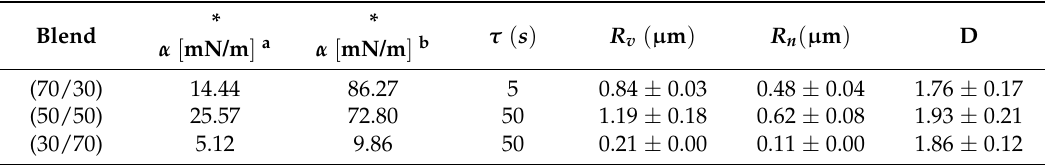
Table 1. The interfacial tension predicted by the Palierne model and the Gramespacher and Meissner model for the 10 min processed blends.